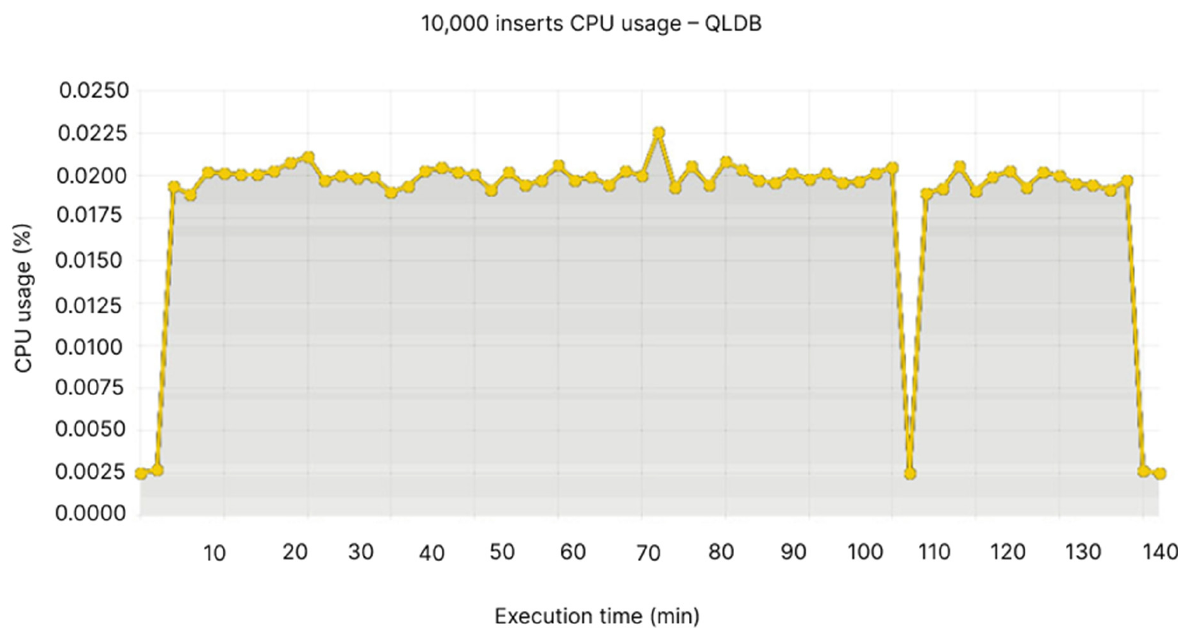
Figure 15. 10,000 inserts CPU usage—QLDB.